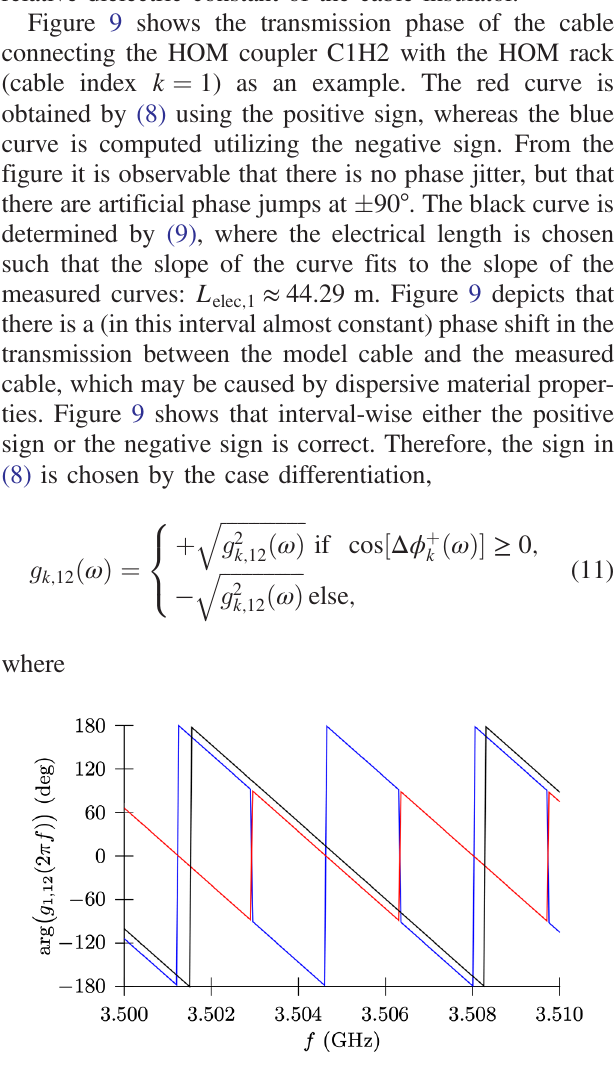
FIG. 9. Example phase response of the transmission of the cable k ¼ 1 . The red curve shows the response obtained by using the positive sign [refer to (8)], the blue curve by using the negative sign, and black curve by using the formula of the model cable (9) with fitted electrical